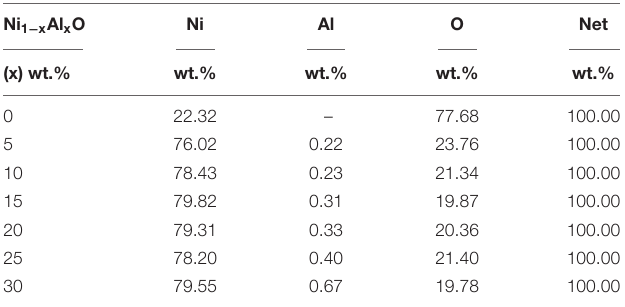
TABLE 2 | Variation of chemical compositions of Ni 1 − x Al x O; x = 0, 5, 10, 15, 20, 25, and 30 wt.% nanoparticles. Ni 1 − x Al x O